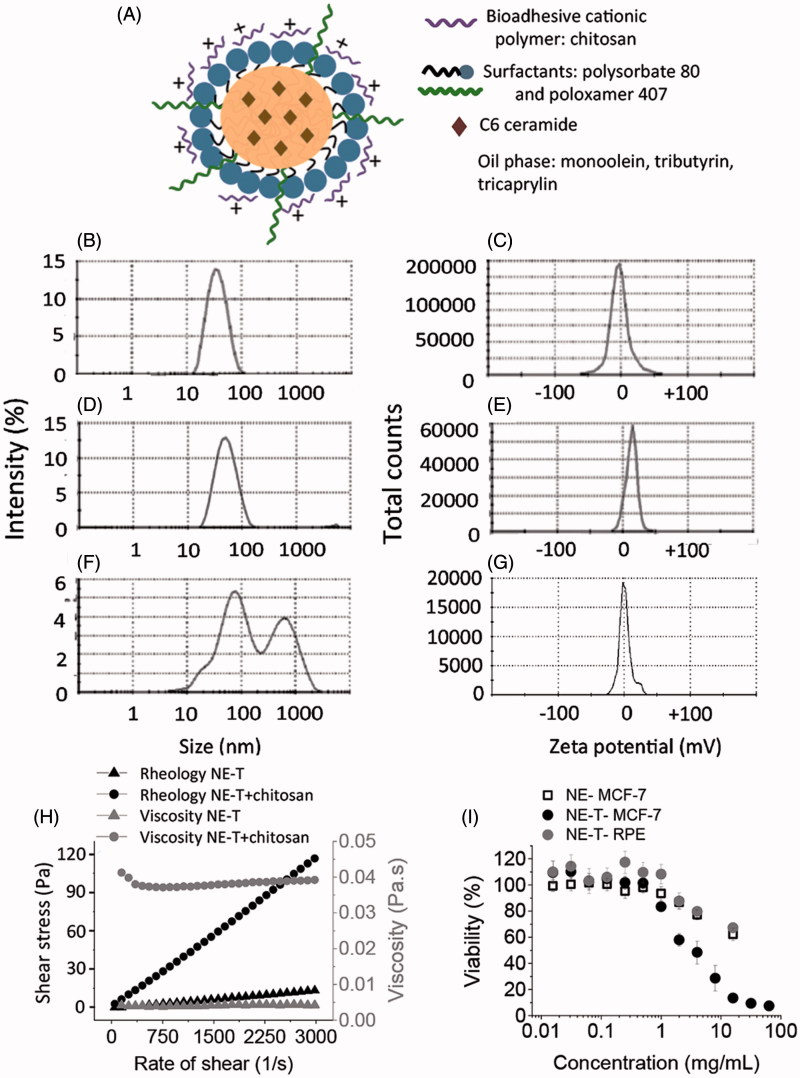
Development and characterization of nanoemulsions. Schematic representation of the loaded nanoemulsion (A), size (B) and zeta potential (C) of formulations obtained without chitosan, size (D) and zeta potential (E) of nanoemulsions obtained with chitosan according to the first protocol (in which chitosan was mixed in the aqueous phase), size (F) and zeta potential (G) of pre-formed nanoemulsions after incubation with chitosan solution (second protocol); all formulations contain tributyrin, and representative graphs resulting from analysis of three formulations from different batches are depicted in these panels. (H) Rheological behavior and viscosity of nanoemulsions with and without chitosan; data shown as average of two samples from different batches. (I) Influence of tributyrin concentration when added into the oil phase on the nanocarrier cytotoxicity against MCF-7 and RPE-cells cells; data shown as average ± standard error, n = 9–12.